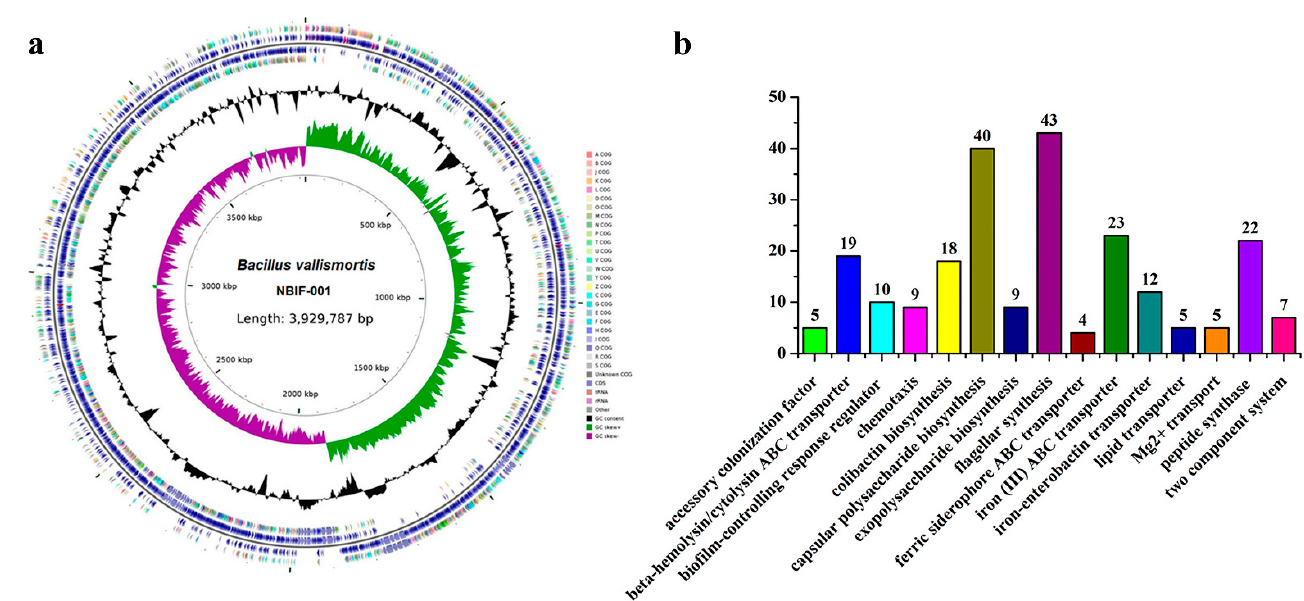
Figure 2. Genomic and acaricidal factors analyses. ( a ) Circular genome map of Bacillus vallismortis NBIF-001 using CG View. The outermost and second circles of all replicons indicate the CDS on the forward and reverse strands, which were coloured according to the COG category. The third and fourth circles show the GC content and GC skew in green (+) and purple ( − ), respectively. The scale is shown in the innermost circle. ( b ) The distribution of functional annotated genes involved in acaricidal activity.